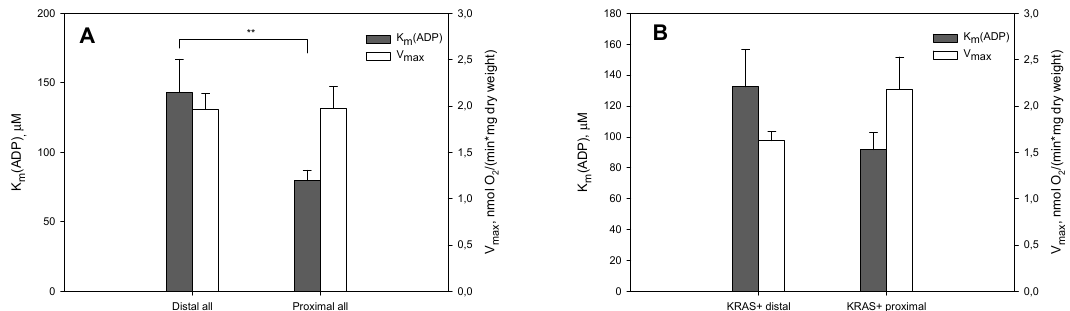
Figure 2. ( A ) In the current study, a comparison of all distal and proximal tumors showed a difference in K m (ADP) values, but not in V max . ( B ) V max and K m (ADP) values comparing proximal and distal tumors in the KRAS mutated group. ** Significant difference, p < 0.01.